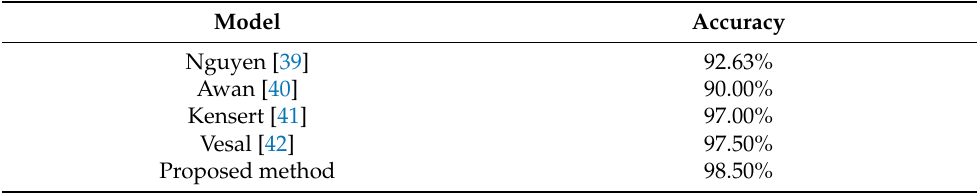
Table 2. Accuracy comparisons with other